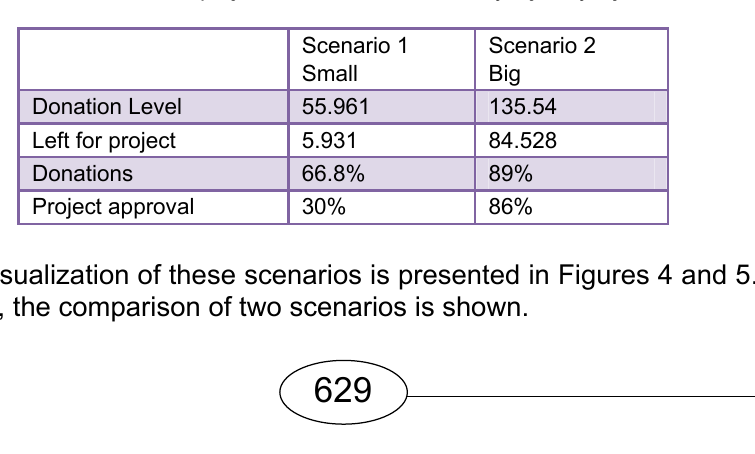
Table 3 – Data comparison after running both scenarios Таблица 3 – Сопоставление данных после изучения